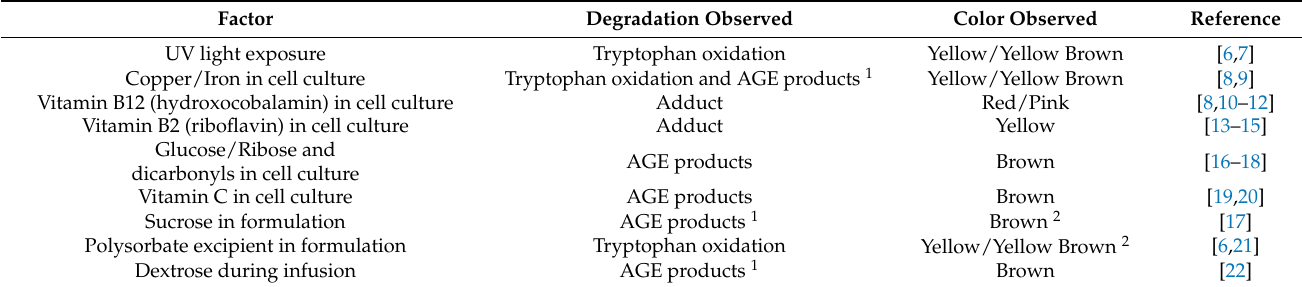
Table 1. Factor potentially inducing color change in